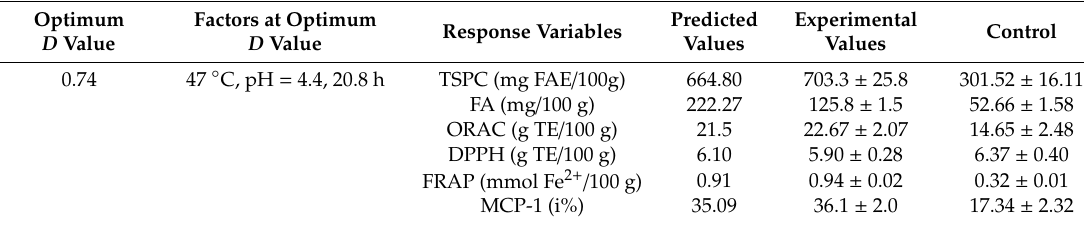
Table 6. Combination of enzymatic hydrolysis factors and predicted values at optimum desirability ( D ) for phenolic content, and antioxidant and anti-inflammatory